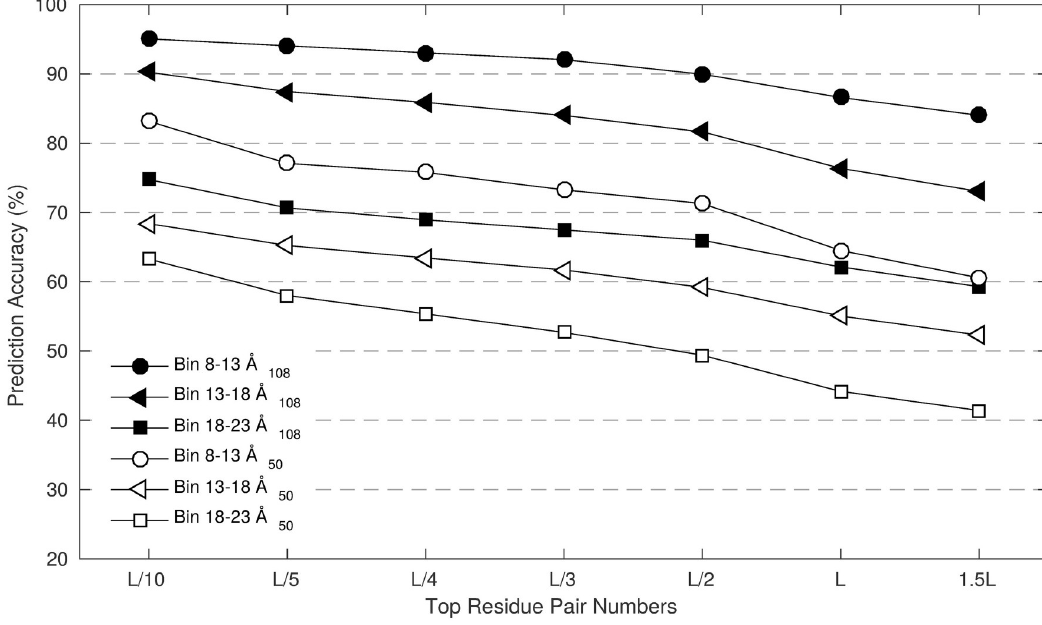
Fig 2. DeepCDpred predicts distances with high average accuracy for both the 108 protein and 50 protein test sets used here.